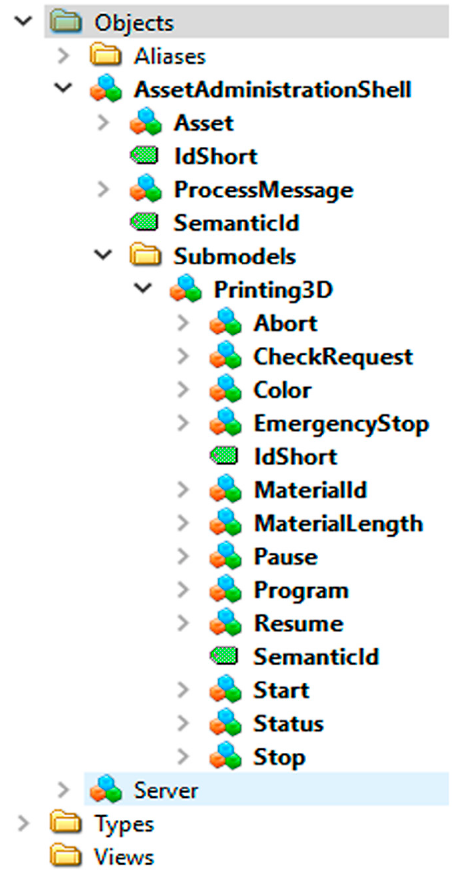
Figure 4. A manually formed AAS.